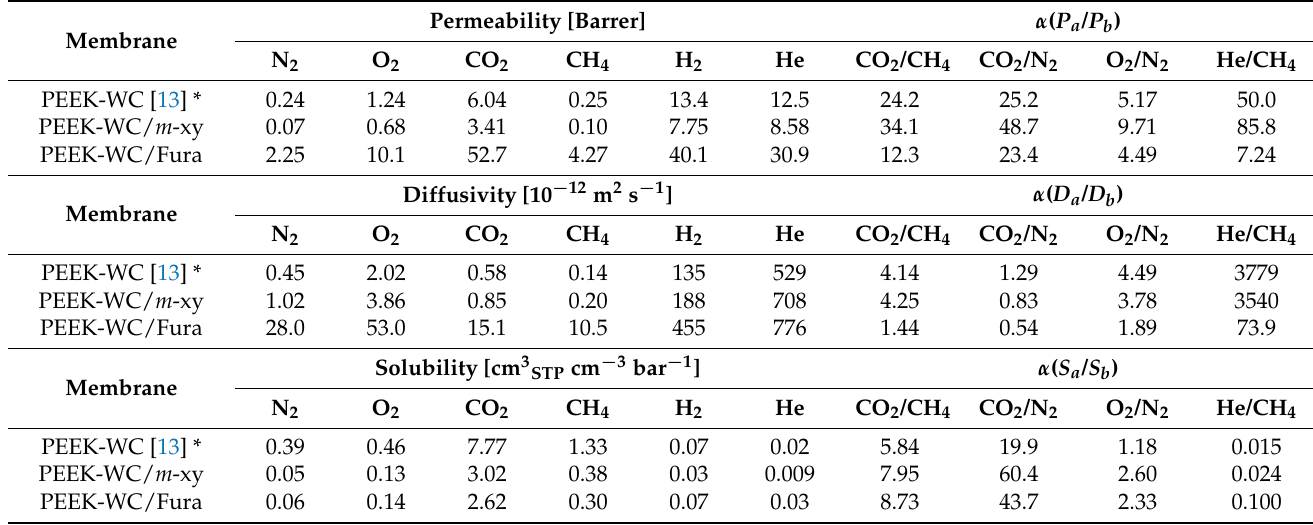
Table 2. Pure gas permeability, solubility, and diffusion coefficients and relative selectivity for the neat PEEK–WC, PEEK– WC/ m -xy, and PEEK–WC/Fura